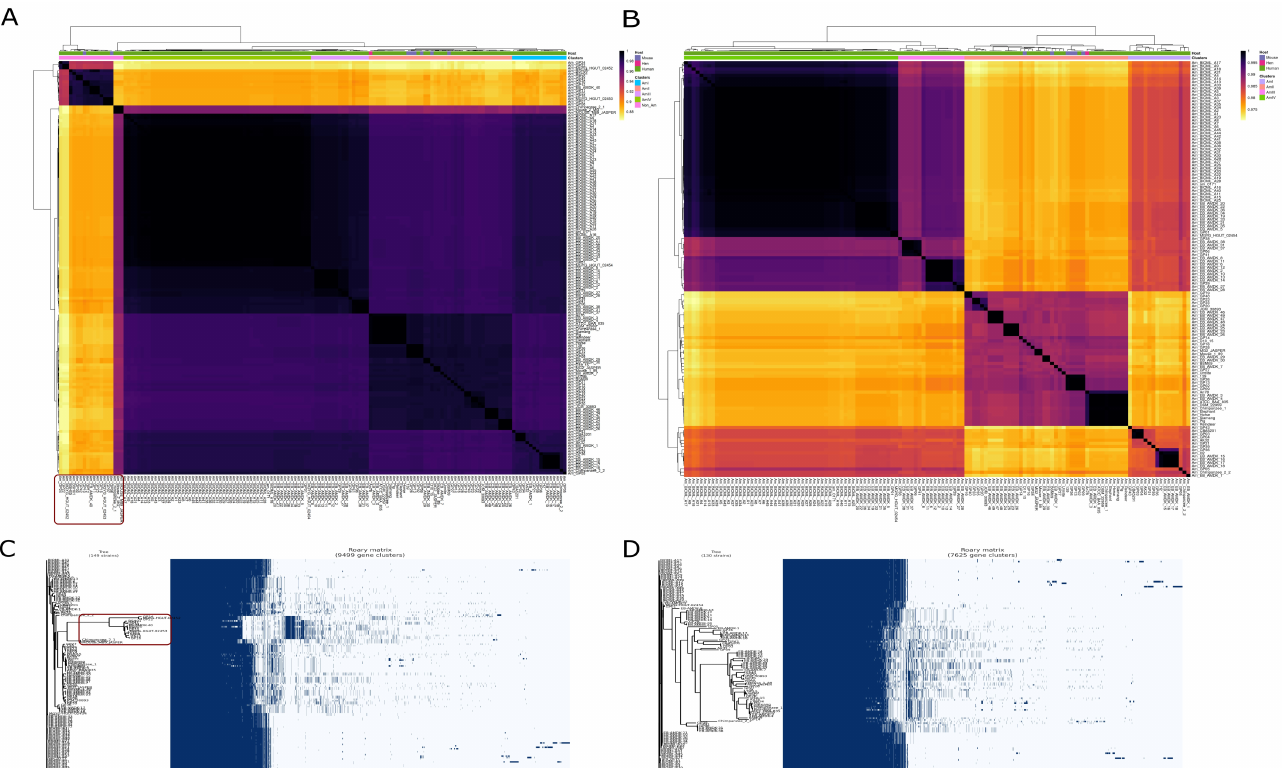
Figure 1. Average nucleotide identity and gene presence-absence profile of initial dataset (149 strains) and final dataset (130 strains). The strains that are too diverse to be incorporated in the final dataset are encircled in both ANI heat map and gene presence-absence profile. ( A ) Average nucleotide identity of 149 strains. A dark red rectangle encircles excluding 19 strains. ( B ) Average nucleotide identity of the final dataset (130) strains. ( C ) Gene presence-absence profile of 149 strains. The dark red rectangle encircles the gene presence-absence profile of the strains to be excluded. The high proportion of genes in these strains is different from the rest of the strains. ( D ) The gene presence-absence profile of 130 strains that were used for downstream analysis after exclusion of confounding